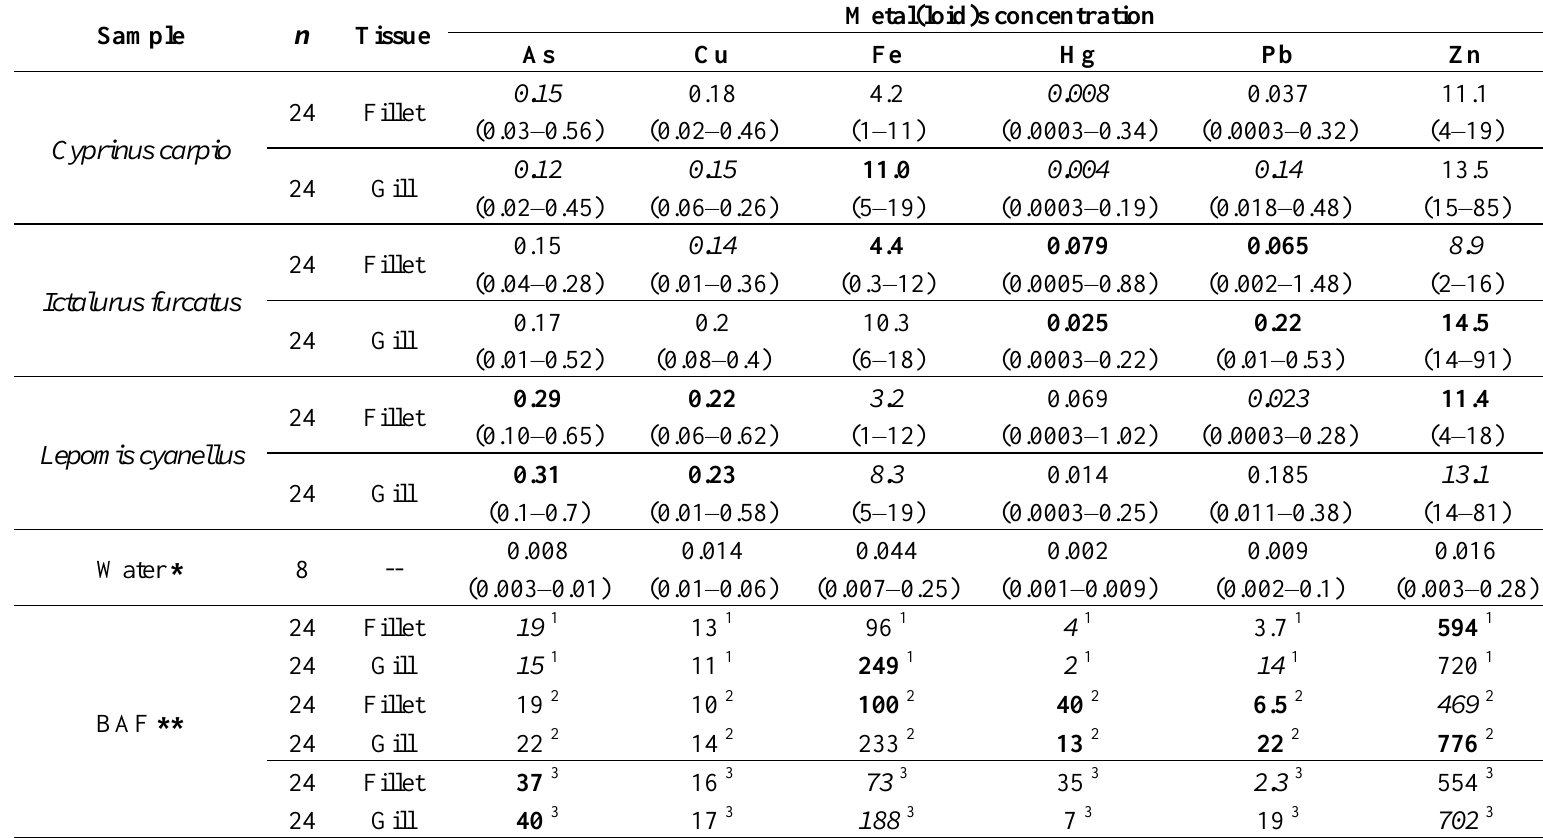
Table 4. Geometric mean values of metal(loid)s concentration in water (mg∙L −1 ), fish tissues (mg∙kg −1 ww) and BAF (L∙kg −1 ) for fillet and gills in fish sampled at Luis L. Leon